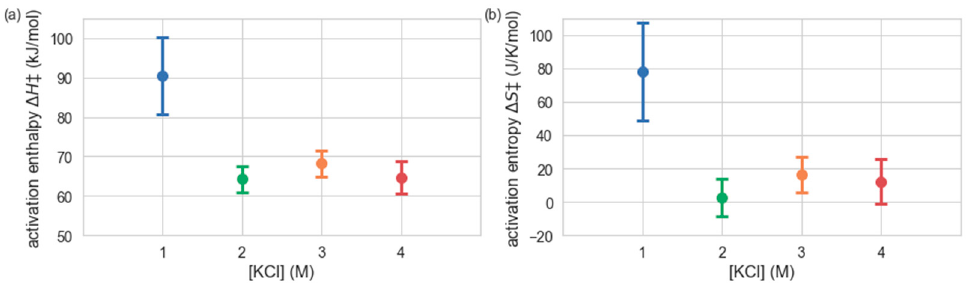
Figure 2. Activation enthalpies ∆ H ‡ ( a ) and activation entropies ∆ S ‡ ( b ), shown as a function of KCl concentration. Values and uncertainties were obtained by Bayesian fitting to temperature-dependent catalytic rates.